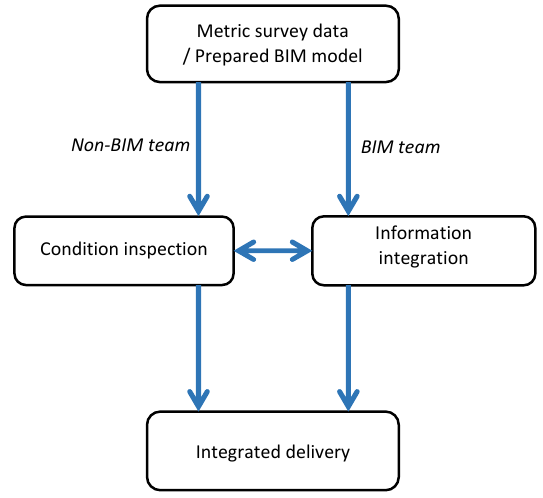
Figure 4 Dual-route